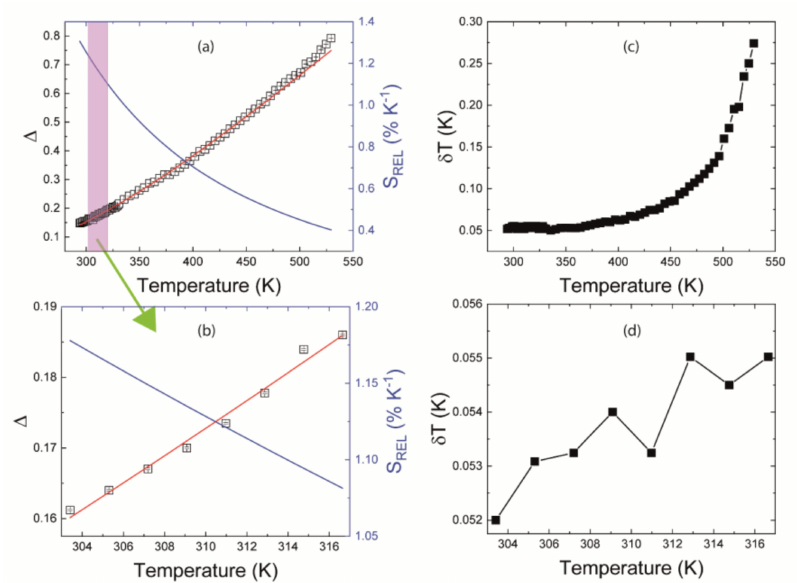
Figure 4. Experimental integrated intensity ratio, ∆ , ( a ) in the whole temperature range and ( b ) in the physiological range of temperature (303 K–318 K), black squares, and relative sensitivity (S REL ), blue lines of the La 2.9 Er 0.1 NbO 7 powder samples obtained from the emission bands associated to the 2 H 11/2 → 4 I 15/2 and 4 S 3/2 → 4 I 15/2 transitions. A Boltzmann type curve was fitted to the experimental values of ∆ according to Equation (1) (red line). Temperature uncertainty, δ T, computed by Equation (3) in the ( c ) whole temperature range as well as ( d ) within the physiological range of temperature. Table 1. Relative S REL thermal sensitivities, temperature range and excitation wavelength of